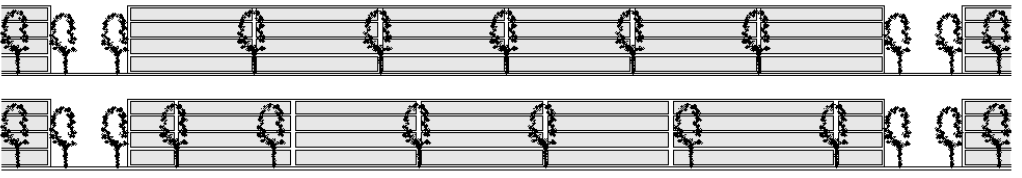
Figure 6. The configuration of trees—T2 scenario (upper—the east–west oriented canyon; lower—the north–south oriented canyon).